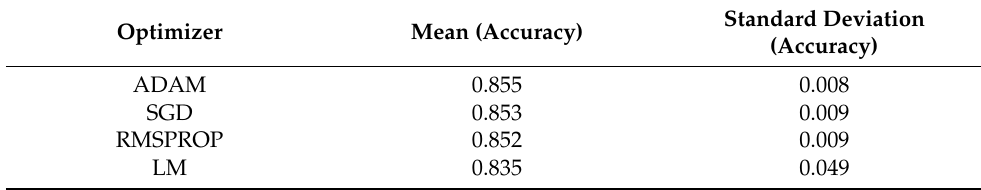
Table 4. Average accuracy values for each optimizer (the higher the best).